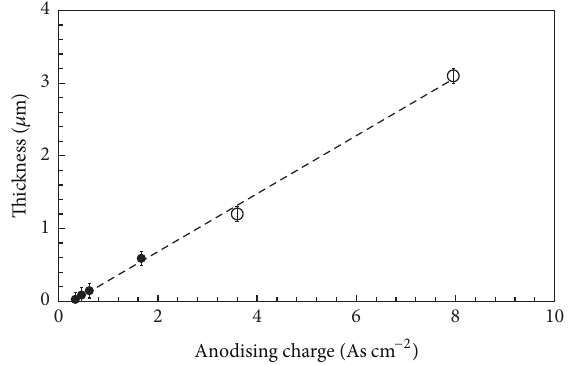
Figure 9: Thickness of the AAO films on EN AW-7075 T73 after potentiostatic anodising in 0.4 M sulphuric acid formed by the micro-capillarytechniqueat0.3 V,1.8 V,3.8 V,and10 V(solidcircles) for 600s and by conventional anodising of circular oxide areas 10mm in diameter at 10V for 1200 s and 3600 s (open circles) as a function of the transferred charge per area